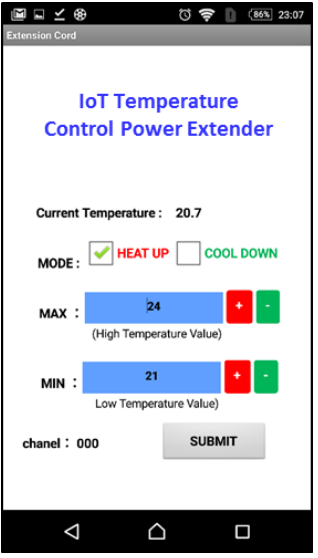
Figure 8. Screen of the mobile device application. The parameters of the proposed extender can also be set via the mobile device application.